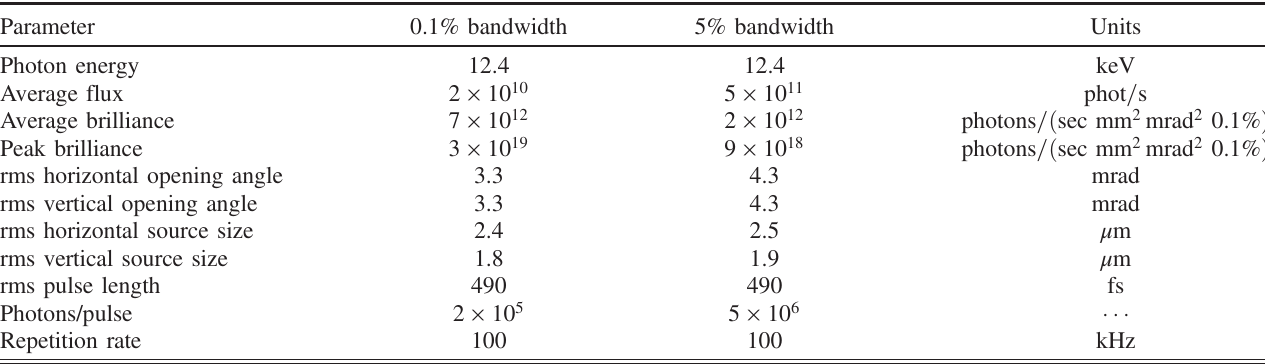
TABLE I. Estimated performance at 0.1% and 5% bandwidth for 12.4 keV x rays from the compact